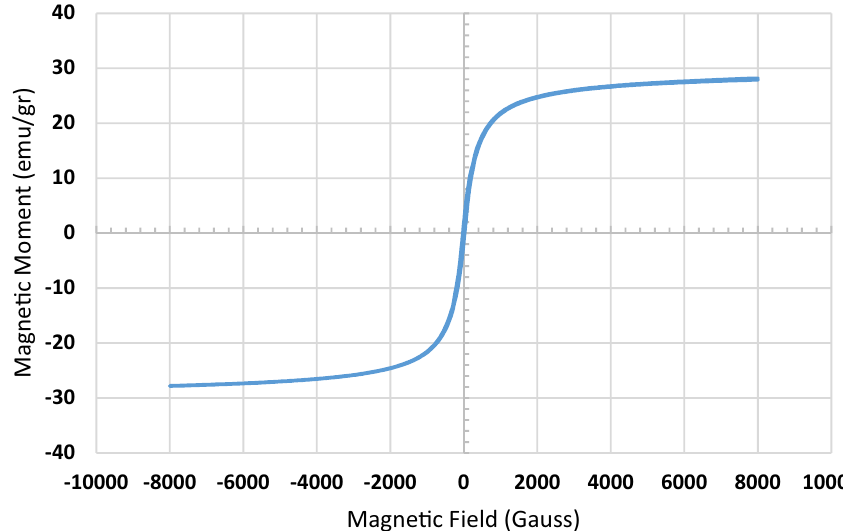
Figure 5. VSM curve of Pip@MGO nanocomposite.